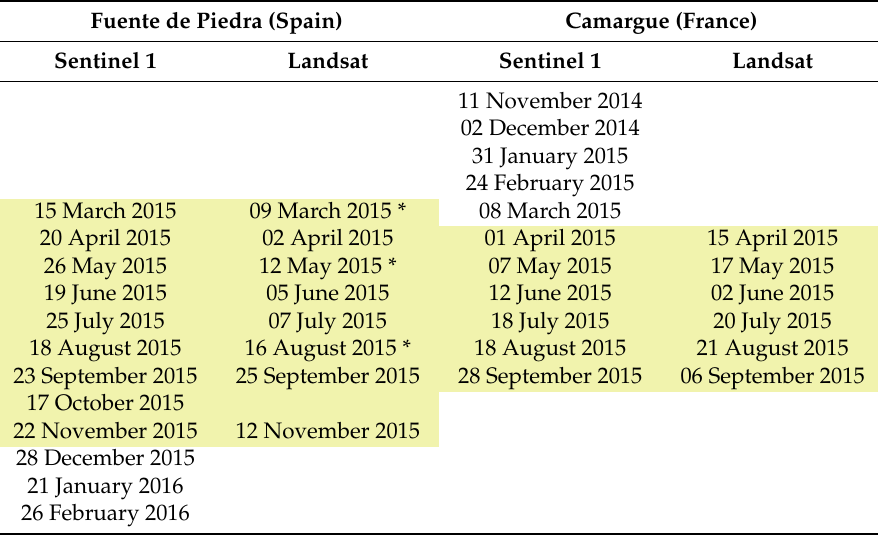
Table 1. Sentinel-1 and Landsat 7, 8 datasets used. Images used for the S1-omnibus and Landsat-based CVA change detection comparison are highlighted. Landsat 7 images are marked with an asterisk (*). Fuente de Piedra